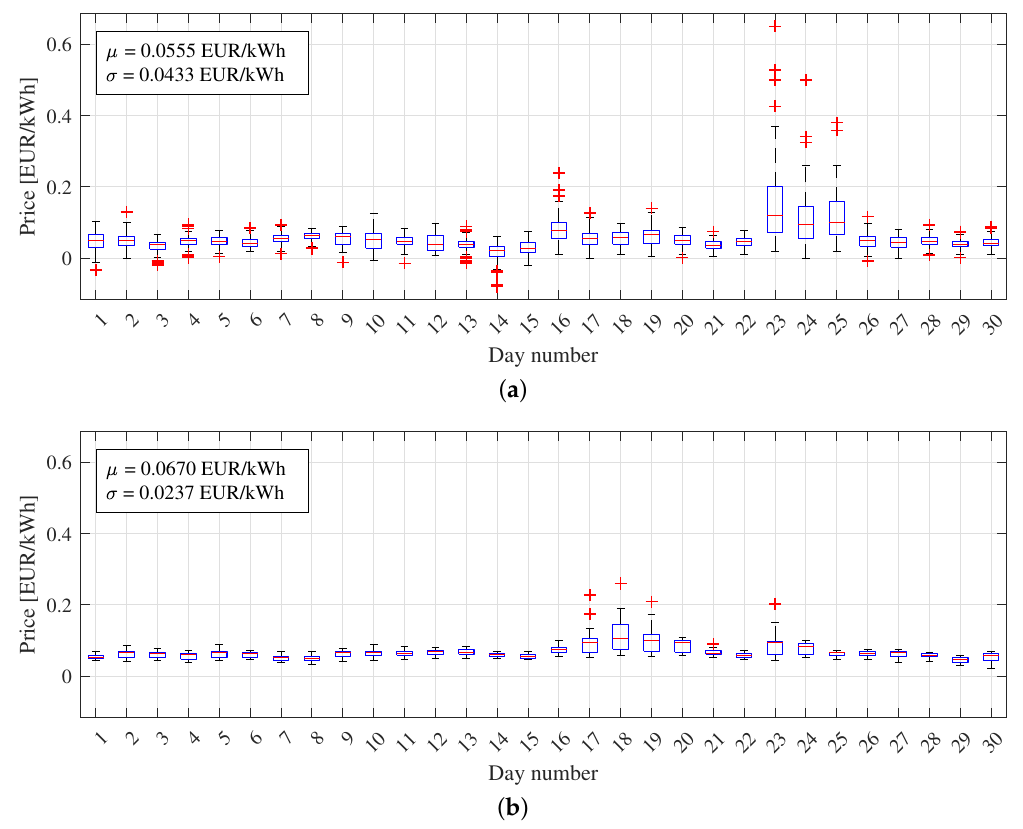
Figure 2. Price distribution for ( a ) the intraday market and ( b ) the day-ahead market [45]. Red lines indicate median values, blue boxes lower and upper quartiles, black whiskers indicate one standard deviation, and red marks indicate